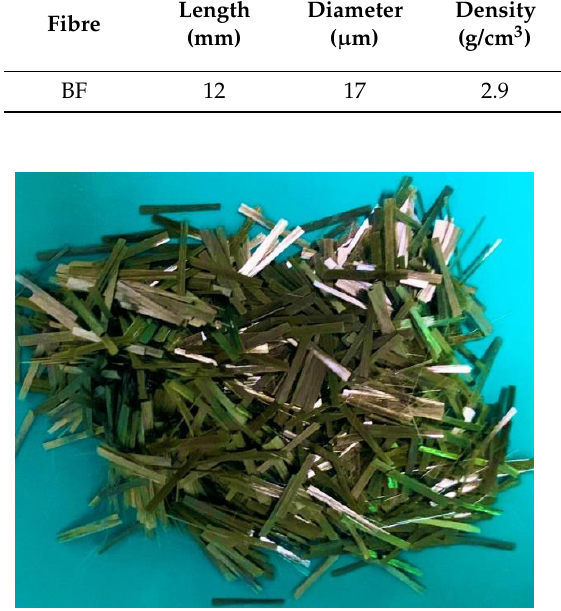
Table 4. Physical properties of basalt fibres.